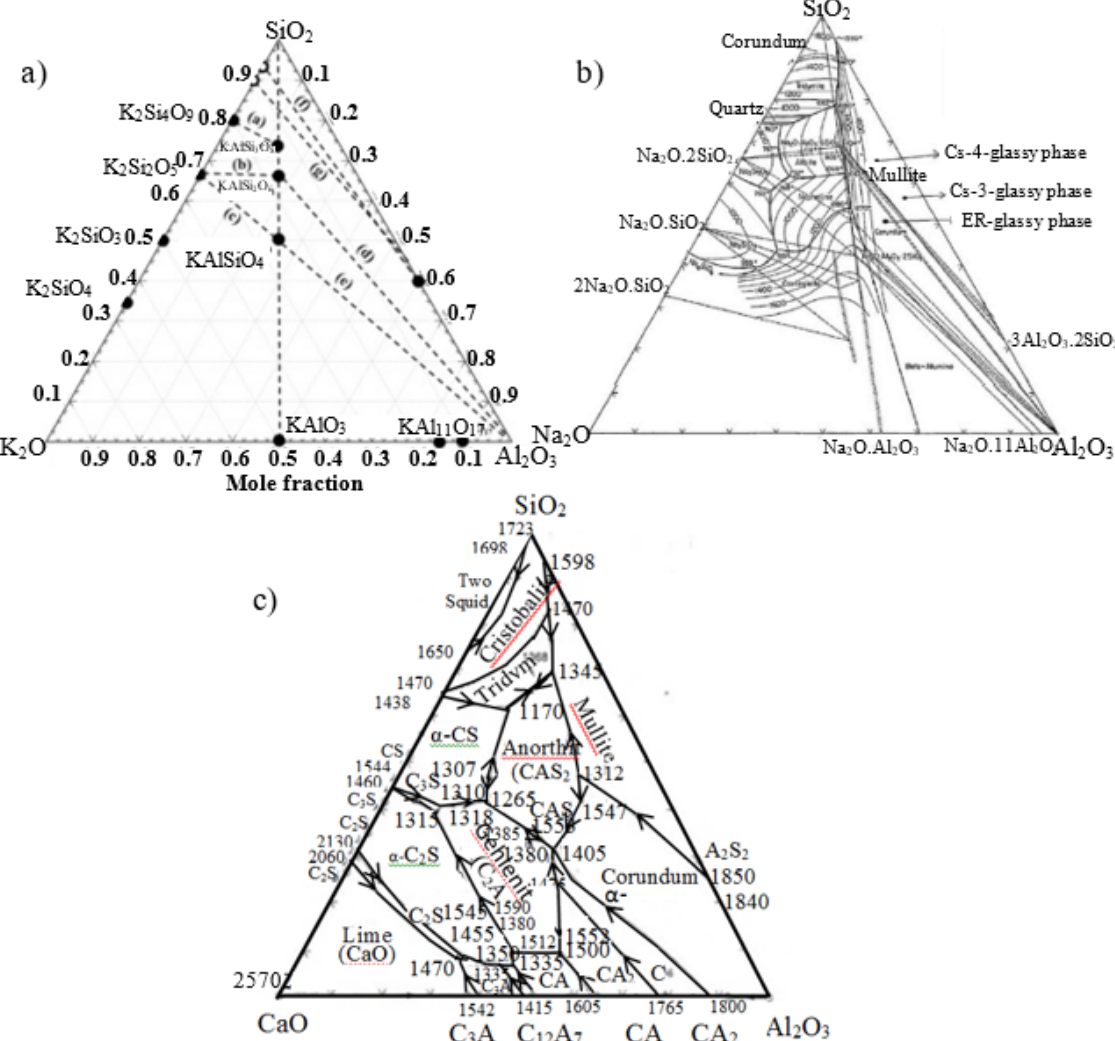
Figure 1: Ternary phase diagram of raw clay powder: a) K 2 O-Al 2 O 3 -SiO 2 , b) Na 2 O-Al 2 O 3 -SiO 2 and c) CaO-Al 2 O 3 -SiO 2